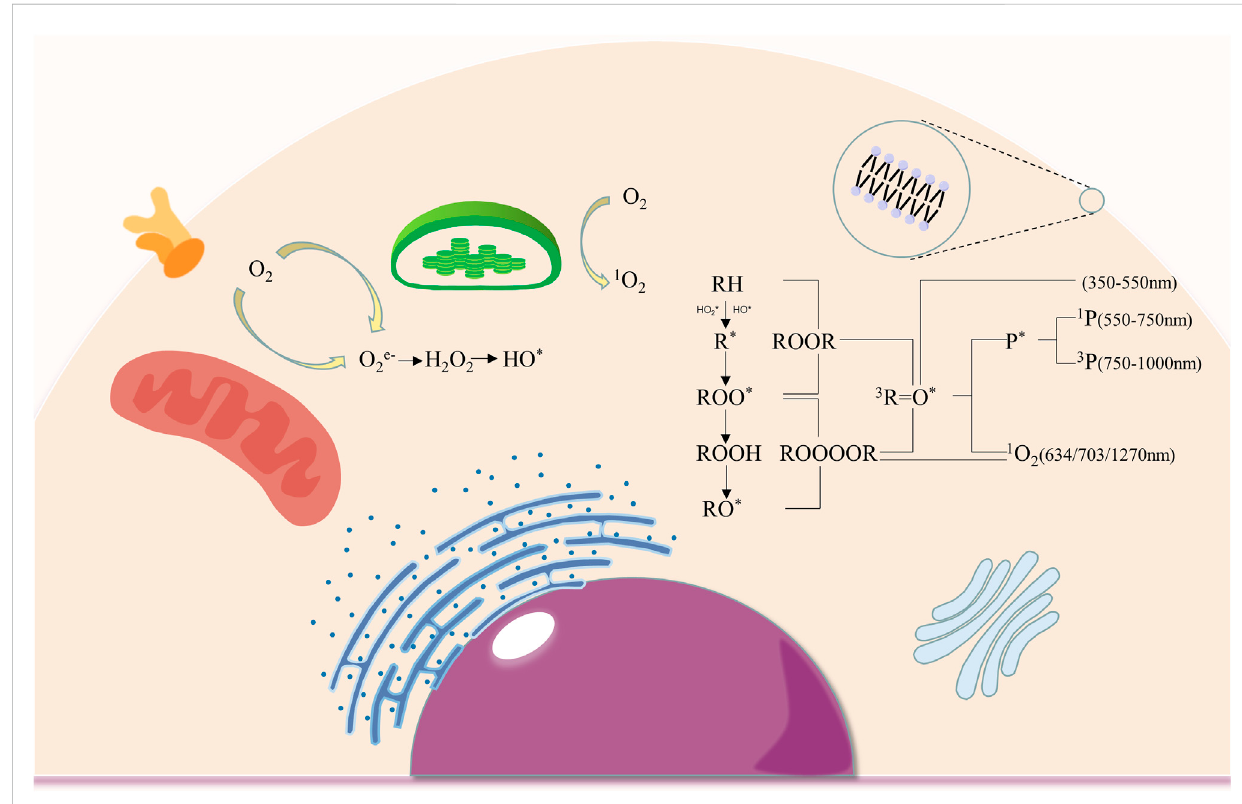
FIGURE 1 The production of intracellular ROS and mechanisms of electronically excited species formation. (ROS production occurs in cell membranes,